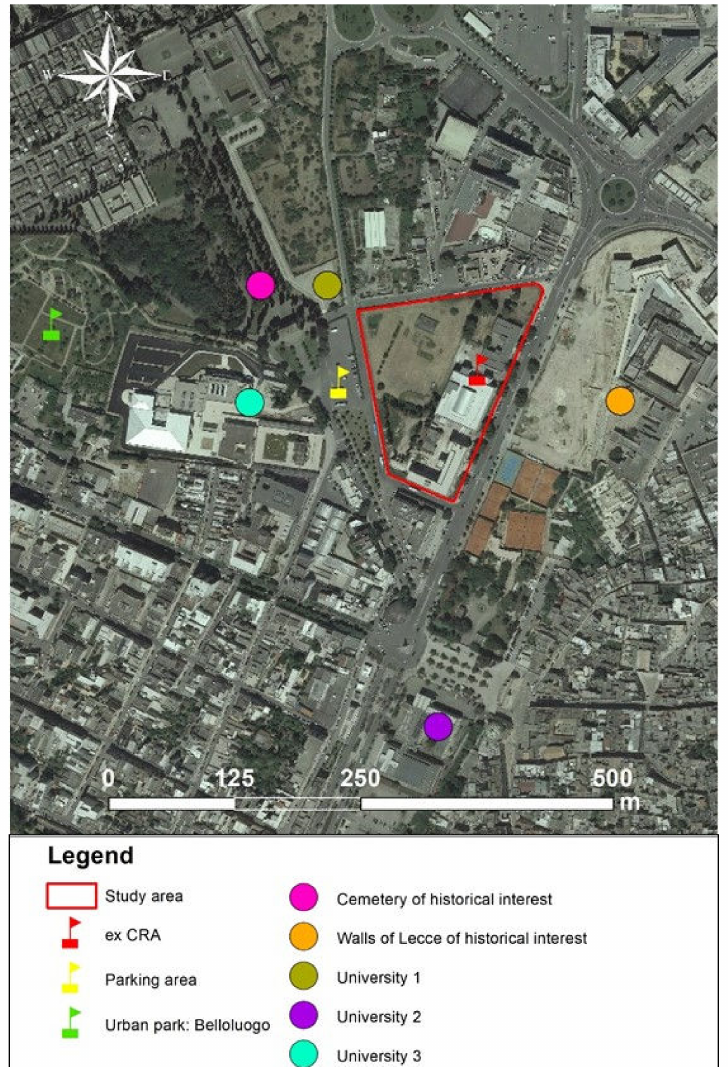
Figure 4. Localization of the points of administration of questionnaires, historical elements, and urban university